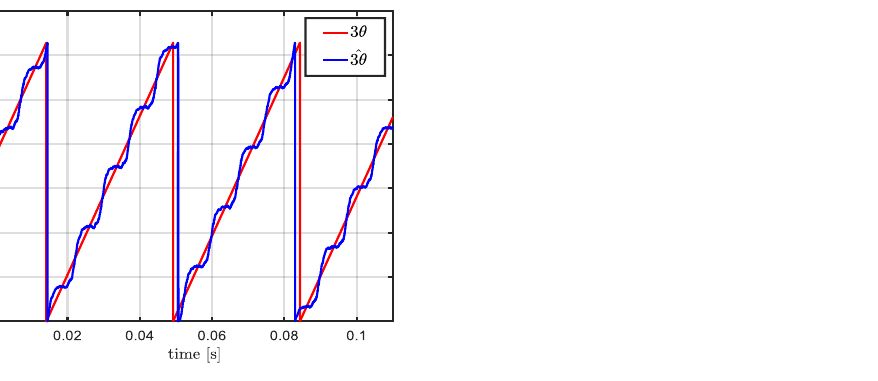
Figure 10. Simulation waveforms: actual rotor position and the estimated position obtained with the estimated back EMF of the 3rd harmonic (TM).